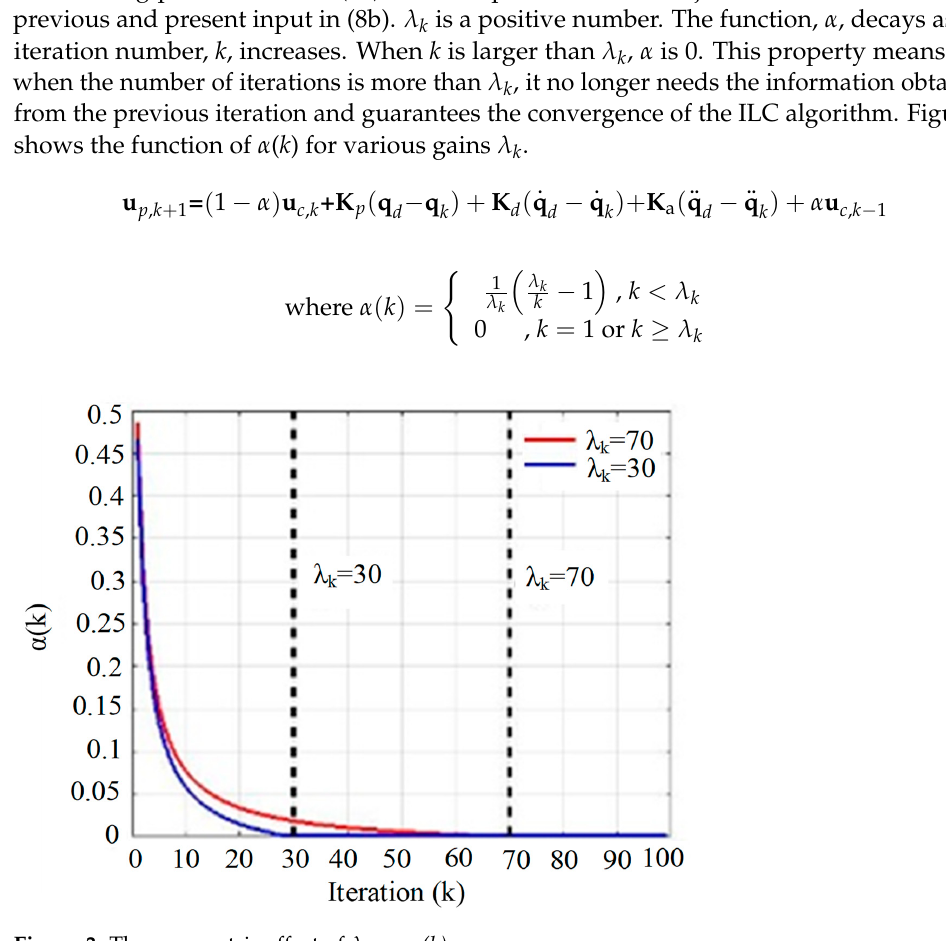
Figure 3. The parametric effect of λ k on α (k)